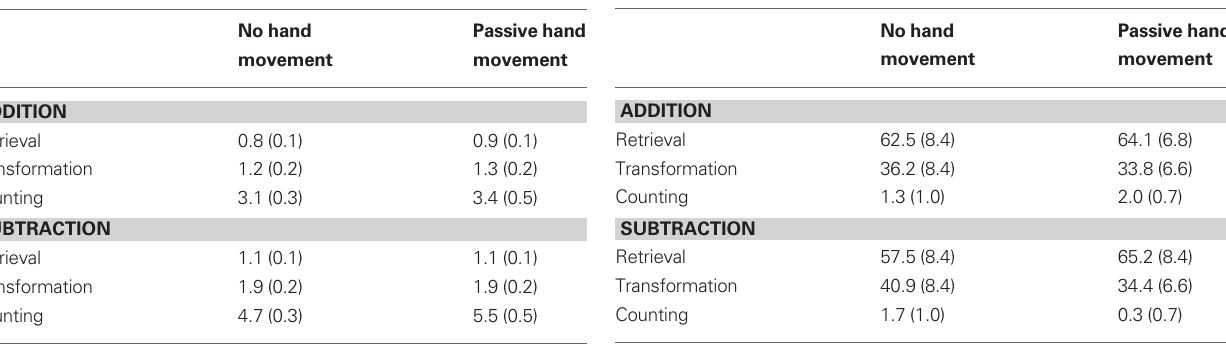
Table 3 | Strategy choices (%) as a function of Operation, Movement, and